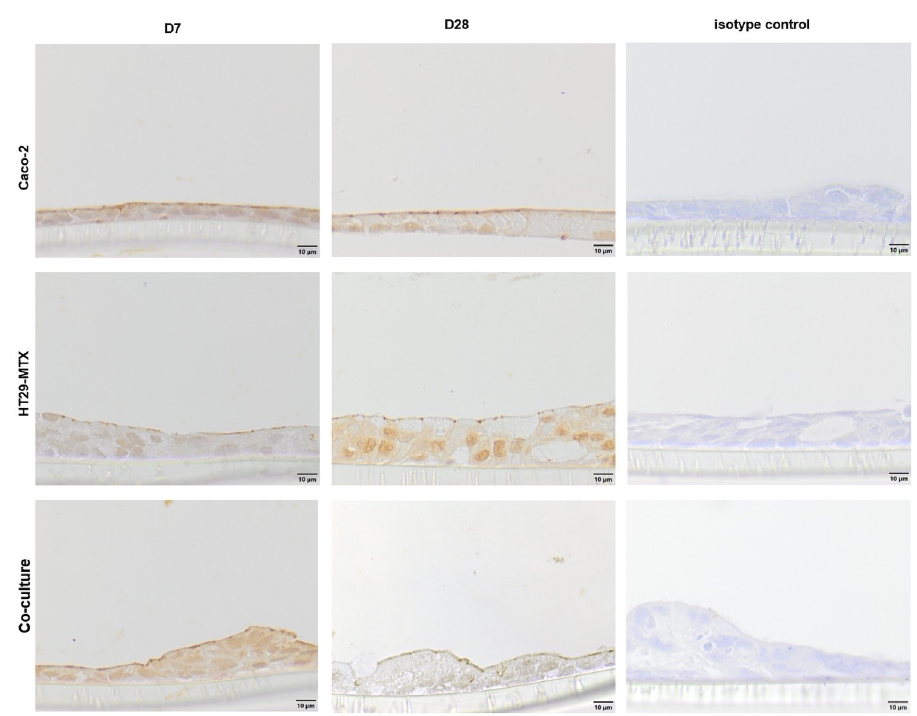
Fig 2. Immunohistochemical staining (including isotype controls) of ZO-1 (cross-section) in Caco-2, HT29-MTX as well as co-cultured Caco-2 and HT29-MTX cells cultivated for 7 (D7) and 28 days (D28). Representative figures are shown, chosen from three independent experiments with three technical replicates per cellular